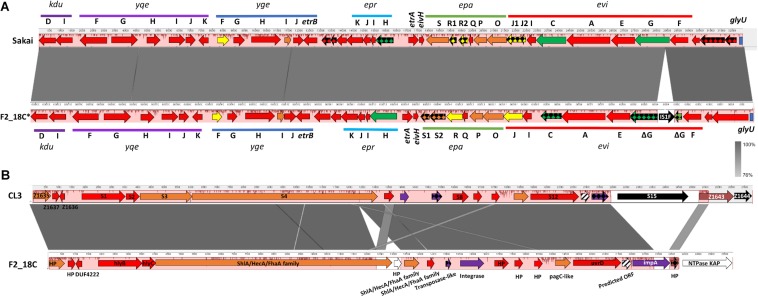
F2_18C pathogenicity island comparisons. Mauve and Easyfig alignments and SnapGene annotations depicting (A) the ETT2 regions in E. coli strains Sakai and F2_18C (F2_18C sequence is depicted in a reversed orientation) and (B) the PAICL3 regions in strains CL3 and F2_18C. The arrow colors represent% amino acid similarity: red = > 95%, orange = > 90%, yellow = > 85%, green = > 60%, purple = > 45%, brown = < 34%, white = ORF not present in CL3, black = ORF not present in F2_18C, checkered = pseudogenes, striped = ORF predicted in F2_18C.